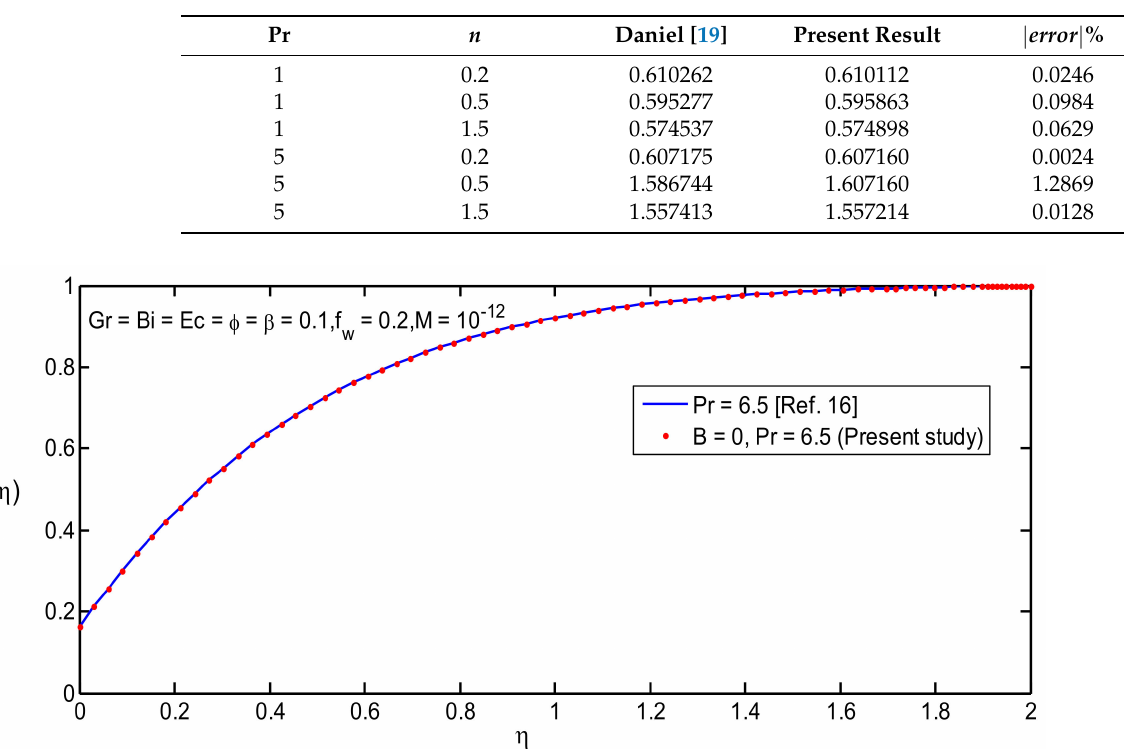
Table 2. Comparison for values of − θ (cid:48) ( 0 ) between different values of n and Pr.